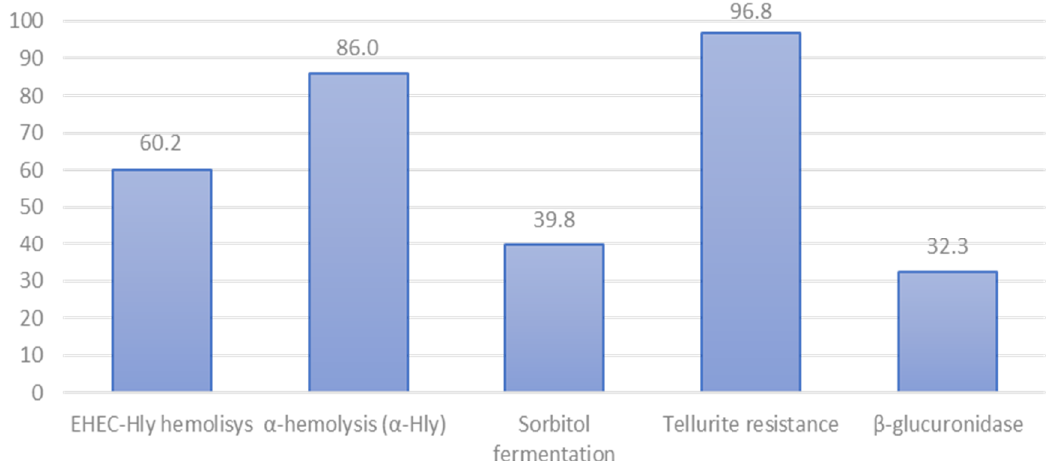
Figure 2. Phenotypic characterization of non-O157 STEC isolated from cattle in Chile ( n = 93) in percentages (%).